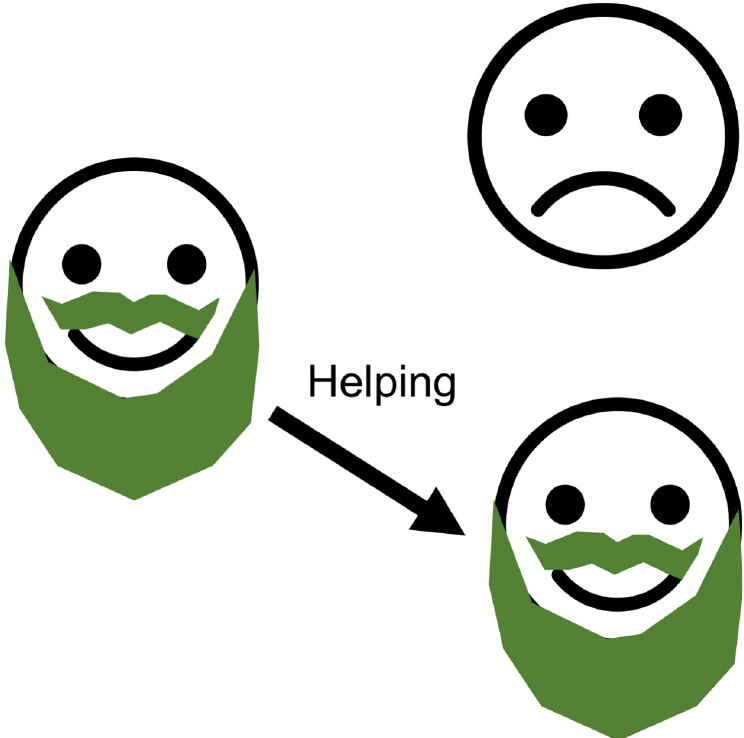
Fig 7. The simplest form of greenbeard mechanism. An individual with the greenbeard allele preferentially helps a fellow greenbeard individual.